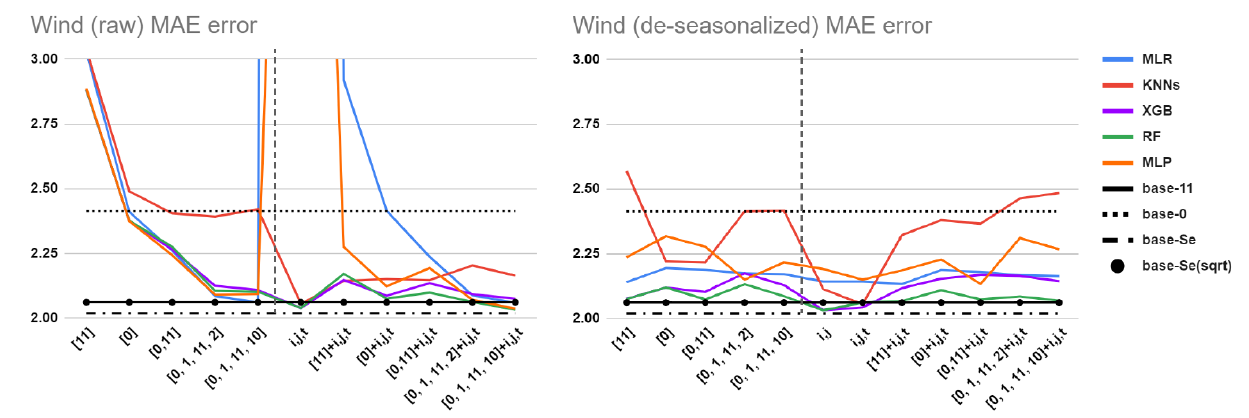
Figure 11. MAE for wind predictions with different feature sets, for raw and de-seasonalized data